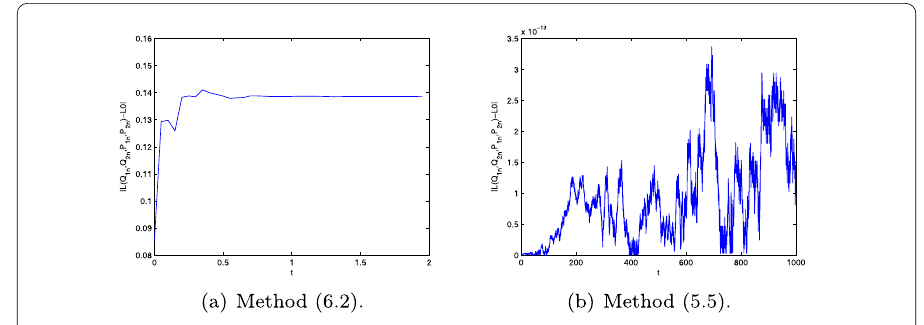
Figure 6 The preservation of the quadratic invariant L of (6.5) with a sample